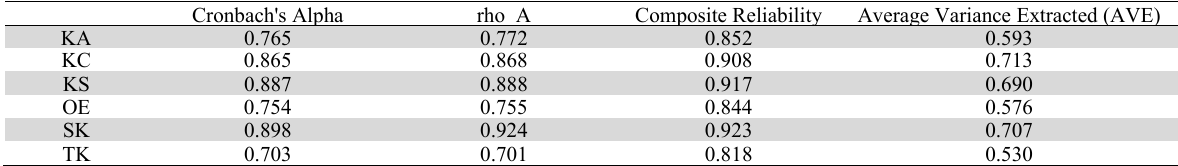
Variables Measurement Model